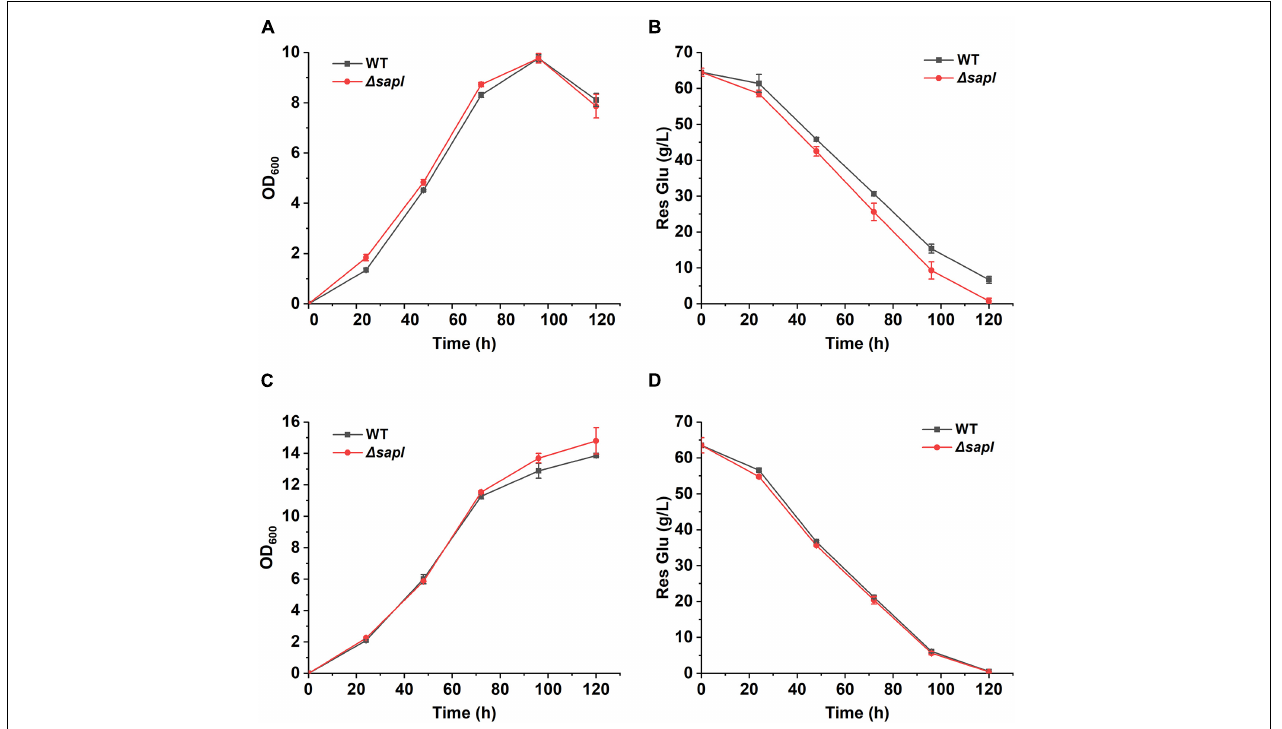
FIGURE 6 | The growth assay of wild-type and (cid:49) sapl with different nitrogen sources. (A,B) Measure the absorbance of OD 600 and residual glucose with ammonium sulfate as nitrogen source. (C,D) Measure the absorbance of OD 600 and residual glucose with yeast extract as nitrogen